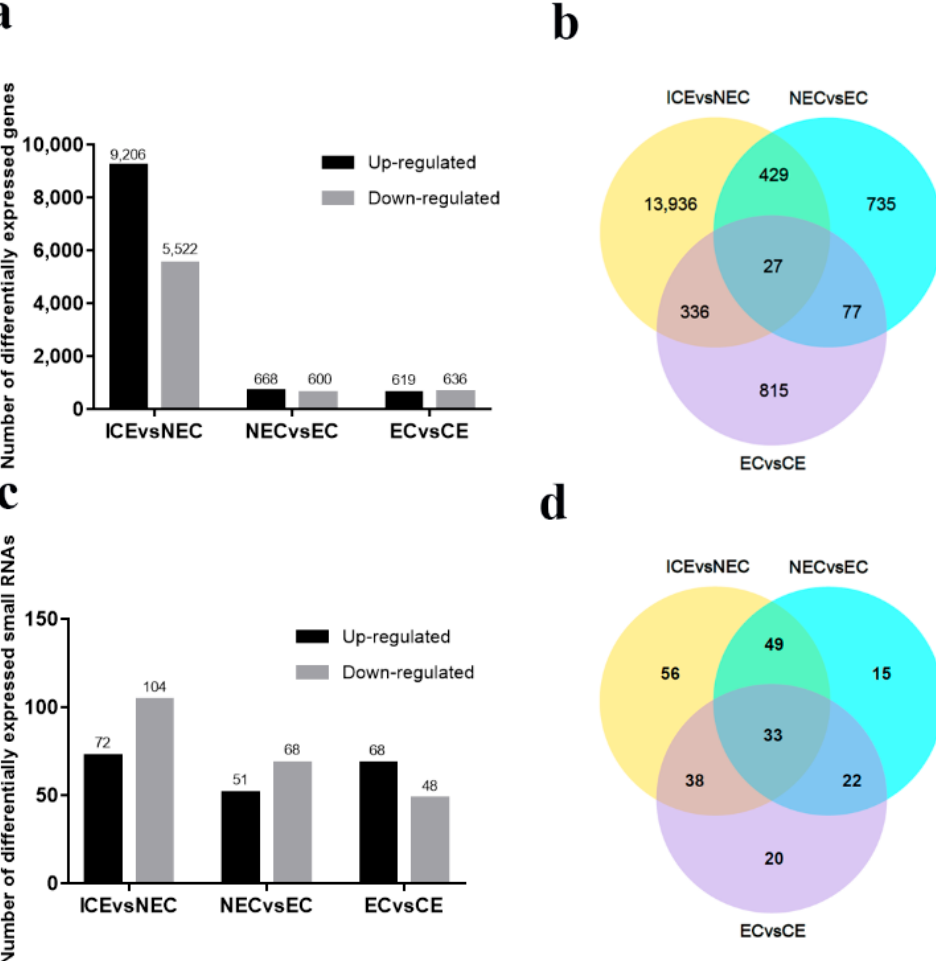
Figure 4. Histograms and Venn diagrams of DEGs for three phrases in SE: embryonic induction (ICE vs. NEC), embryonic induction (NEC vs. EC), and maturation (EC vs. CE). ( a ) The numbers of DEGs up- or down-regulated during SE; ( b ) Venn diagram showing similarly or differently regulated genes over the three phreases; ( c ) The numbers of small RNAs up- or down-regulated during SE; ( d ) Venn diagram showing similarly or differentially regulated small RNAs during SE.